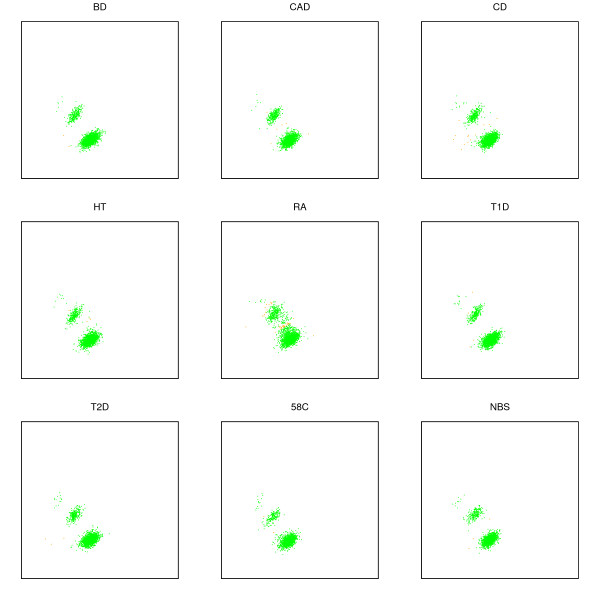
Cluster plots for SNP rs4988327 in the WTCCC data. Note the high spread for RA, and the resulting increase in no-calls (orange) relative to calls (green).